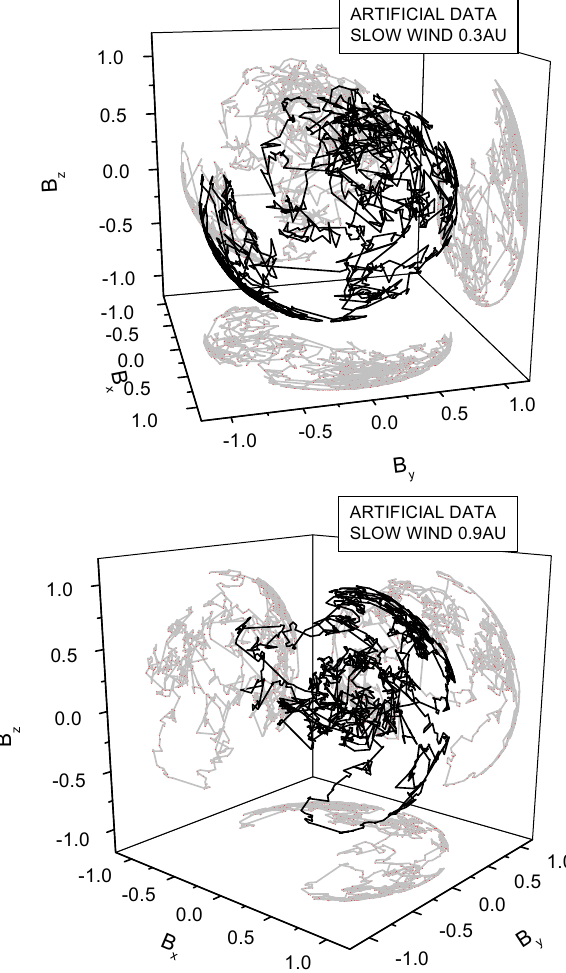
Fig. 13. Three-dimensional representation of vector displacements relative to artificial data generated by a random-walk, whose jumps obey a double-lognormal, whose parameters have been obtained by the best fit of real fluctuations. The top and bottom panels refer to a slow wind at 0.9 and 0.3AU, respectively, and have to be compared to analogous plots for real data shown in Fig.